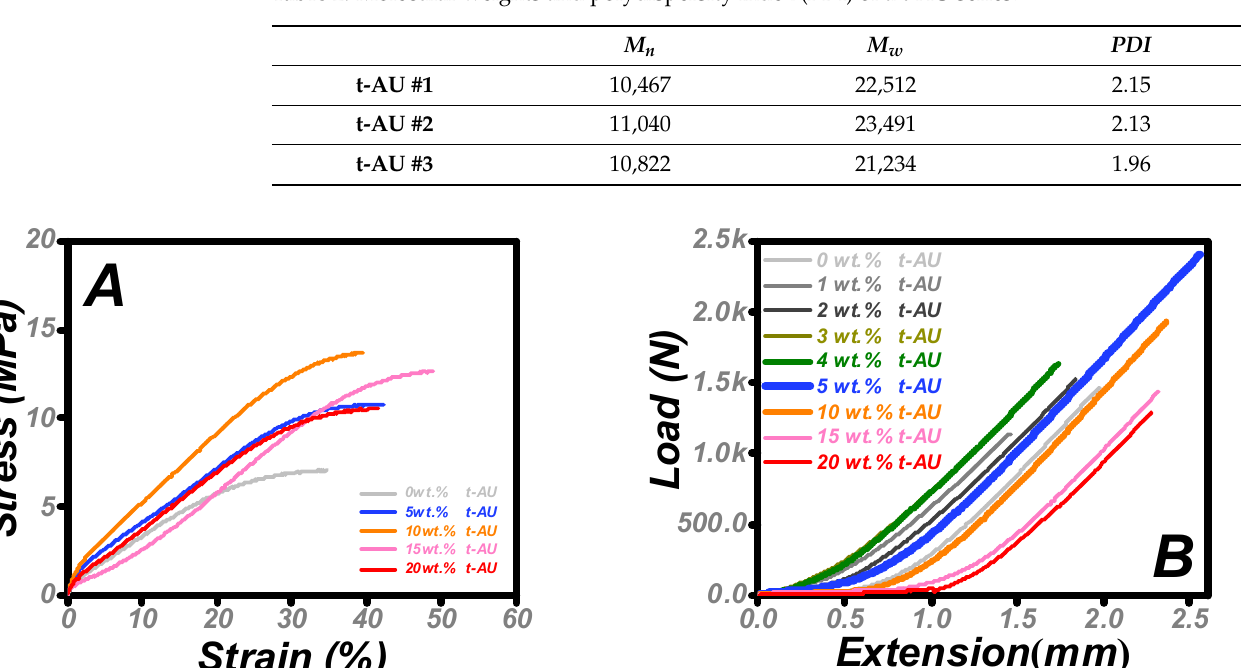
Figure 3. Tensile strength ( A ) and shear strength ( B ) of AUPs as a function of the t-AU content. The gel fraction and average crosslink density were measured to confirm the curing degree of the AUP at room temperature. The average crosslink density of the AUP series was obtained according to Equations (1) and (2).